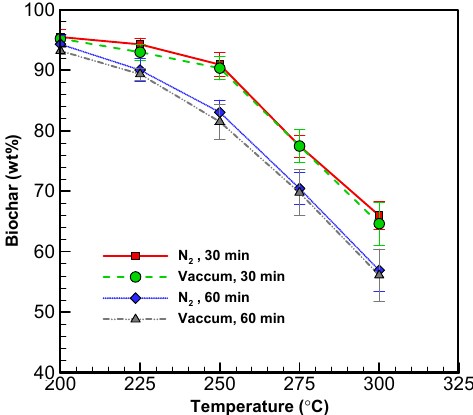
Figure 2. Profiles of solid (biochar) yield from wood sawdust torrefaction.